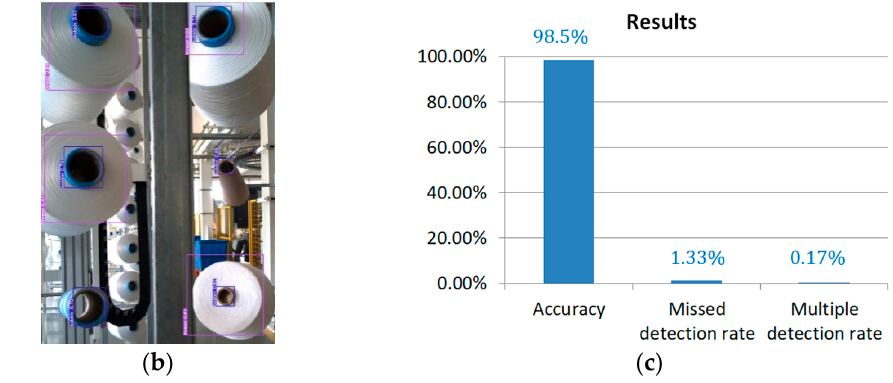
Figure 5. Yolo model detection results. ( a ) Detection results. ( b ) Detection results. ( c ) Measured error.